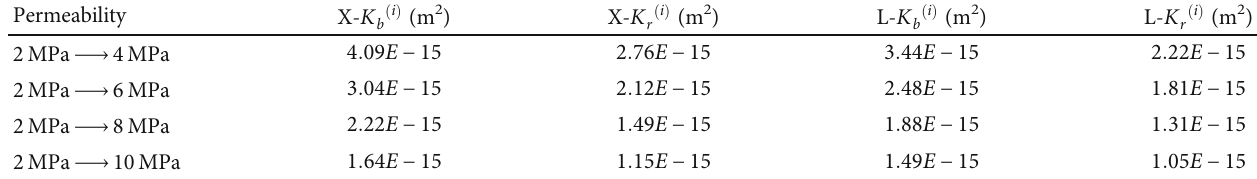
Table 10: The permeability evolution during the loading-unloading process with the axial strain 2.01%. Permeability